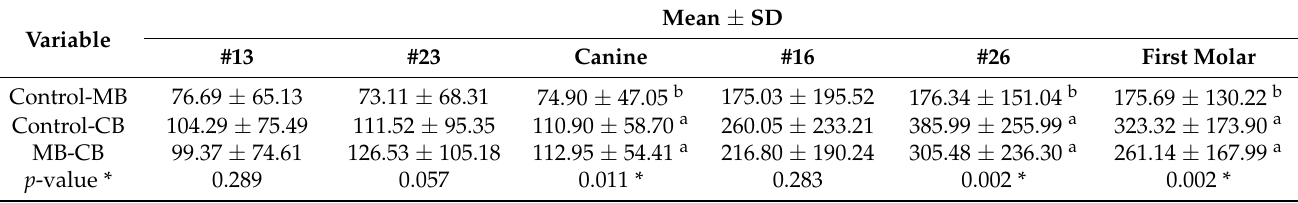
Figure 4. Average deviations on scanned images according to buccal bracket. Control = control group (the model without a bracket); MB = MB group (the model with a metal bracket); CB = CB group (the model with a monocrystalline bracket); Control-MB = distance between control group and MB group on canine tip and first molar mesiobuccal cusp; Control-CB = distance between control group and CB group on canine tip and first molar mesiobuccal cusp; MB-CB = distance between MB group and CB group on canine tip and first molar mesiobuccal cusp. Table 3. Average deviations of right and left reference points on scanned images according to buccal bracket (unit: µ m).